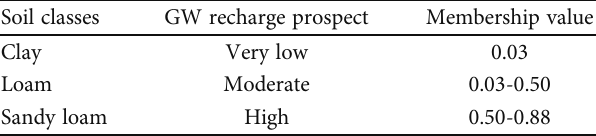
Table 5: Soil classes, membership value, and